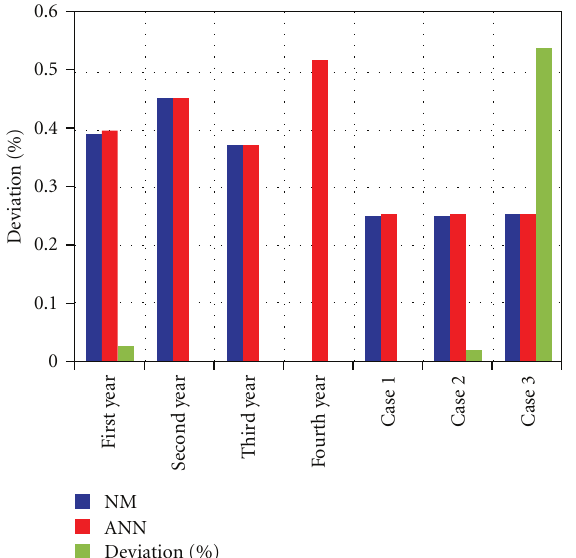
Figure 7: Total SAIDI values with deviation for whole system less than